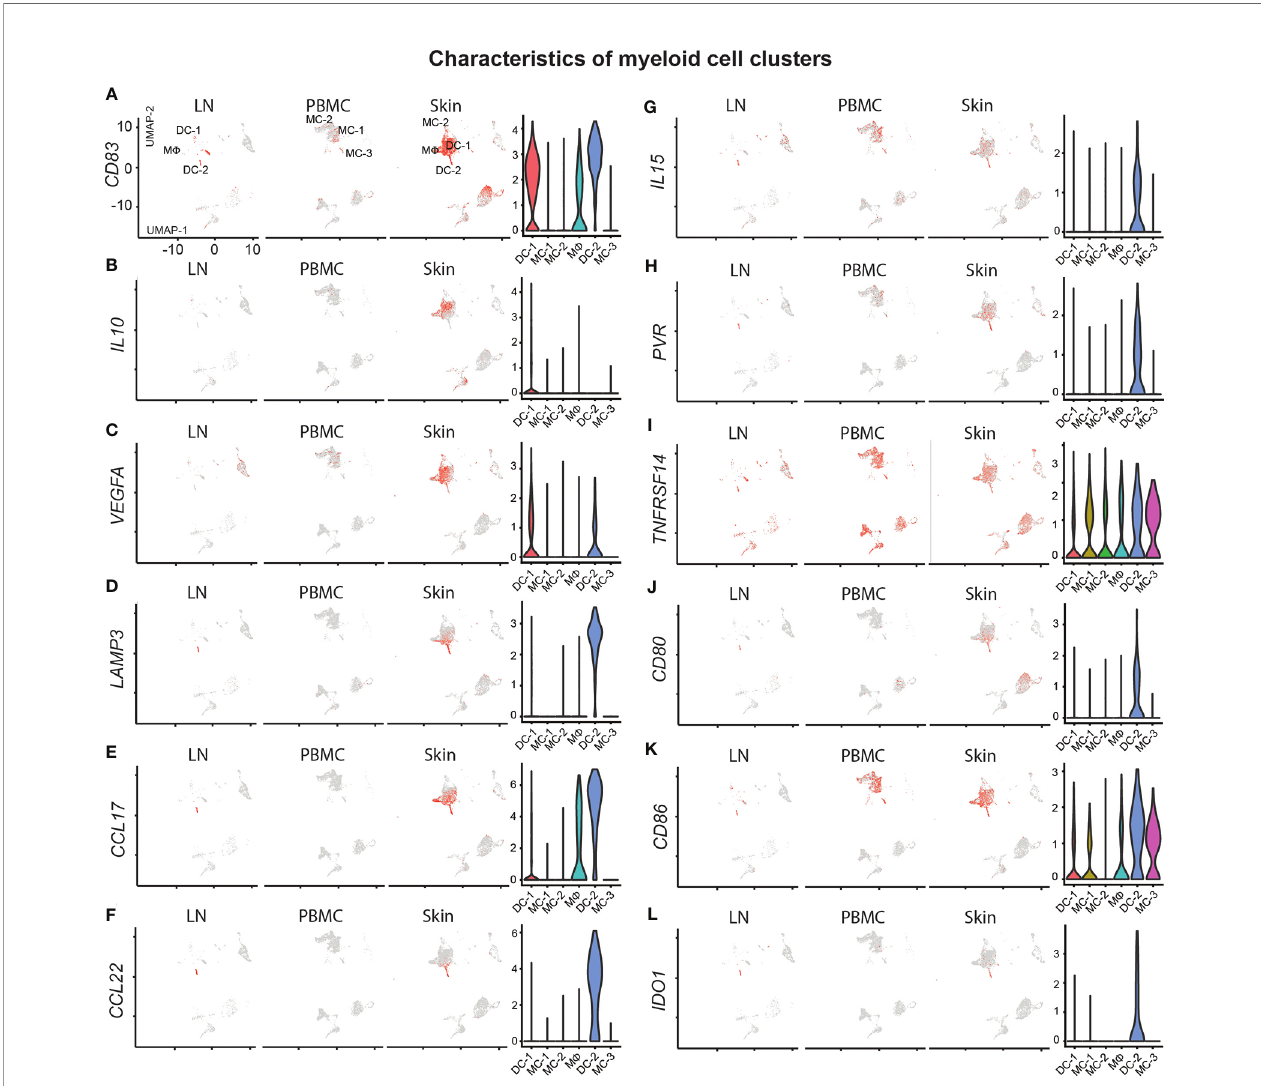
FIGURE 5 | Characterization of myeloid cell clusters. (A – L) For feature plots, normalized expression levels for each cell are color-coded (red) and overlaid onto separate UMAP plots for lymph node (LN), blood (PBMC) and skin. Intensity of color re fl ects respective level of expression. Violin plots of the combined samples show the distribution of normalized gene expression levels of the respective genes in color-coded DC-1, MC-1, MC-2, M F , DC-2 and MC-3